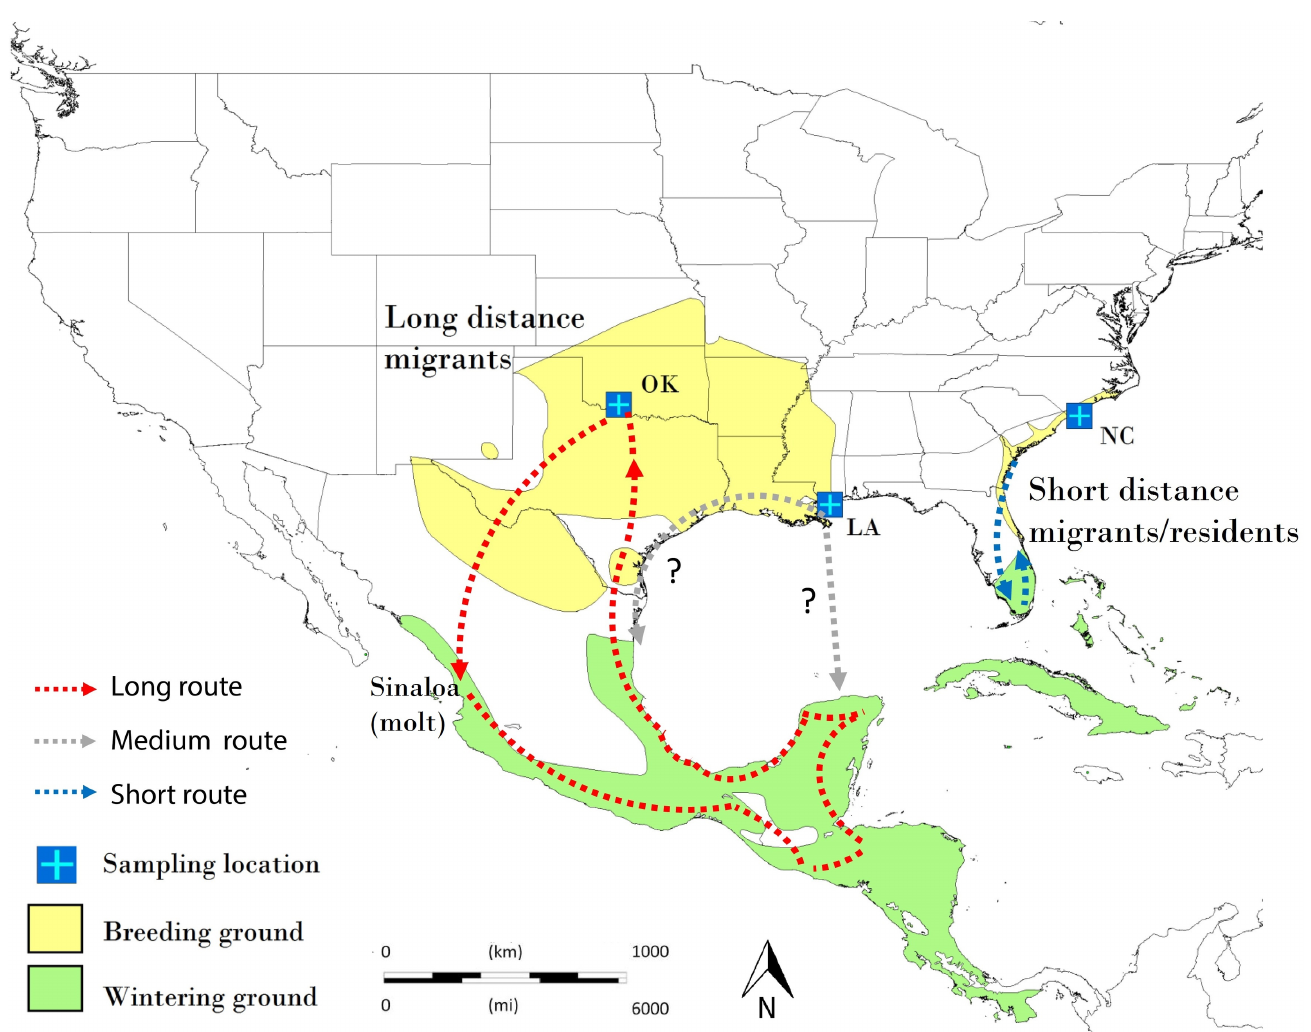
Fig 1. Painted Bunting distribution. The breeding and wintering ground are indicated in yellow and green, respectively. Blue crosses indicate sampling locations in Oklahoma (OK), Louisiana (LA) and North Carolina (NC). Dotted-line arrows and question marks indicate hypothetical migratory routes.